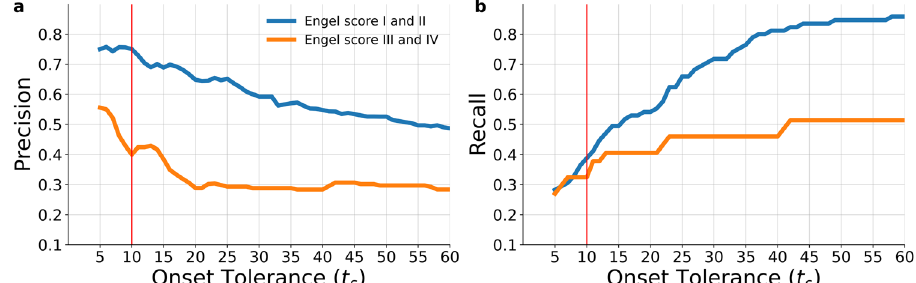
Fig. 7 Precision and recall across various onset tolerance thresholds. a Precision of both the patient groups as the onset tolerance threshold t ϵ is varied from 1 to 60 s. b Recall of both the patient groups as the onset tolerance threshold t ϵ is varied from 1 to 60 s. The red vertical line represents the onset tolerance used in previous results of this